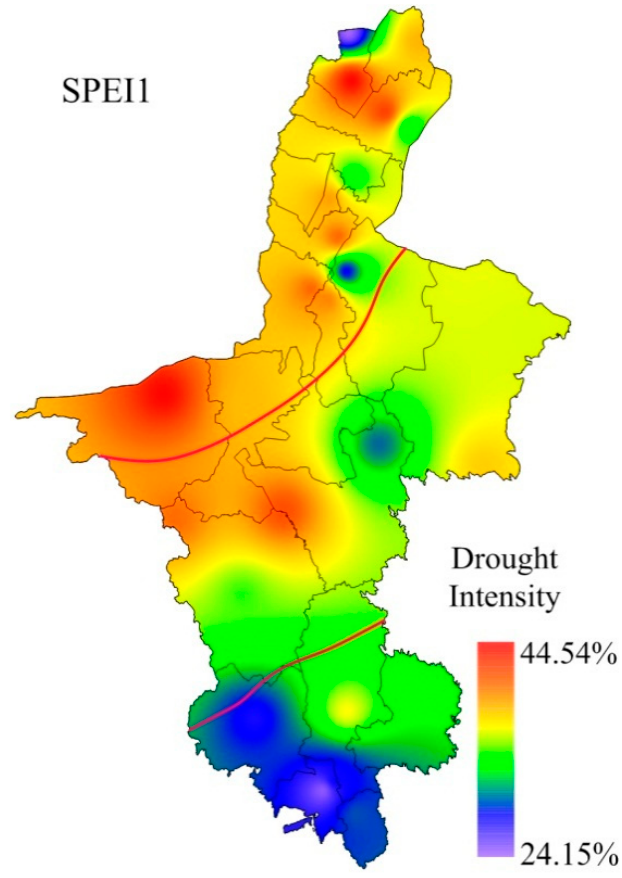
Figure 8. Spatial distribution of drought intensity in Ningxia.